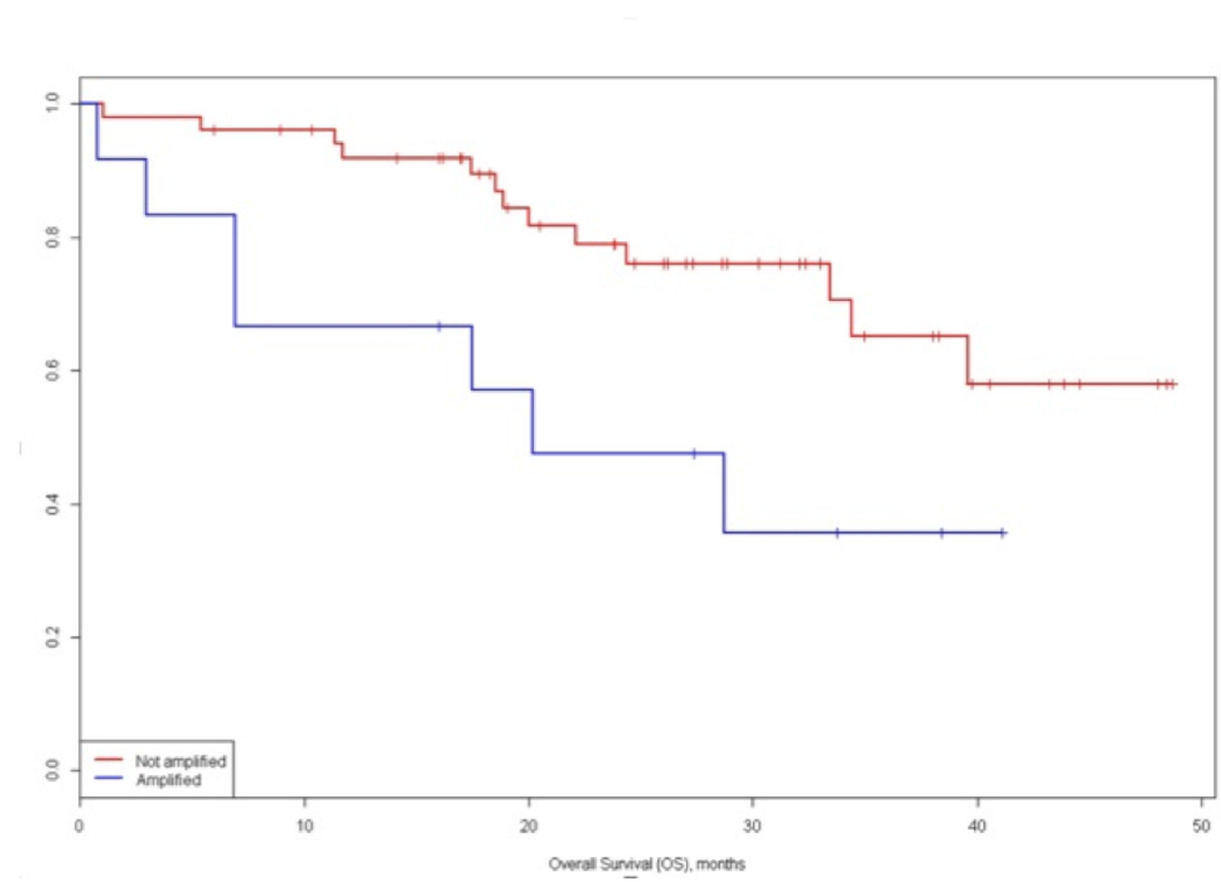
Figure 4. Overall survival (OS) of c-myc amplified vs. not-amplified groups. doi: